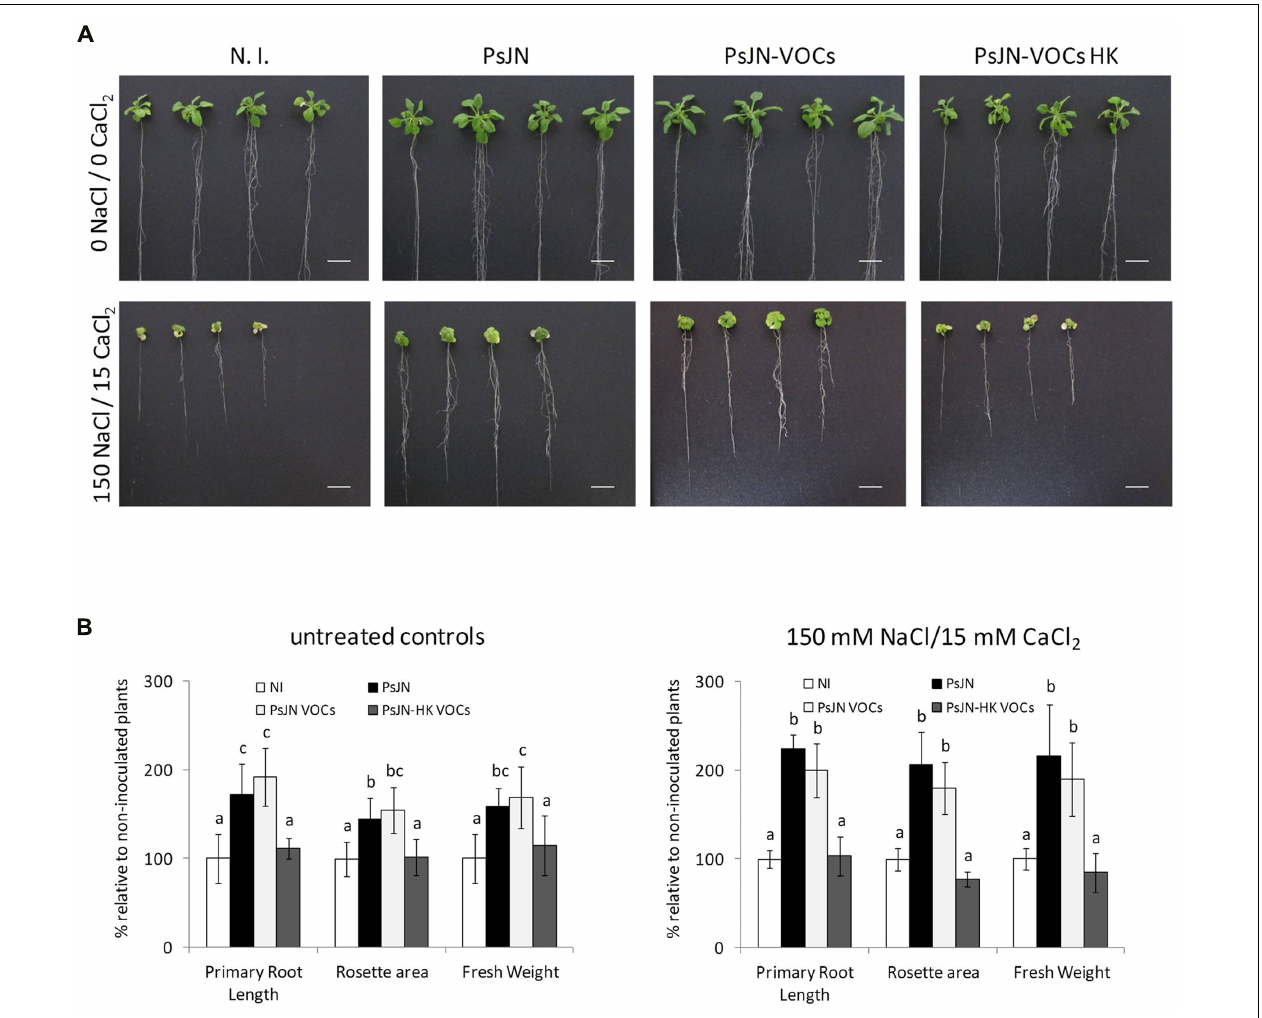
FIGURE 4 | Volatile organic compounds-mediated stimulation of A. thaliana tolerance to salinity. Root growth, rosette diameter and fresh weight were measured for A. thaliana col-0 plants inoculated with P. phytofirmans (PsJN), non-inoculated (N.I), or exposed to volatile emissions from live PsJN (PsJN-VOCs) or a heat-killed inoculum (HK-PsJN-VOCs) (see Materials and Methods). Plants were transferred at 11 DAS to fresh MS 1 / 2 agar with no added NaCl or CaCl 2 (0 NaCl/0 CaCl 2 ) as untreated controls ( A , upper row; B left panel), or MS 1 / 2 agar with 150/15 mM NaCl/CaCl 2 ( A , lower row; B right panel). Growth parameters were registered at 21 DAS. Bars show mean percentage values relative to N. I. plants, and the error bars indicate standard deviations from experiments with 30 plants analyzed for each bacterium and salt treatment. Different letters indicate statistically significant differences among bacterial treatments within each salt concentration for each measured parameter (One way ANOVA Tukey’s HSD tests; p <